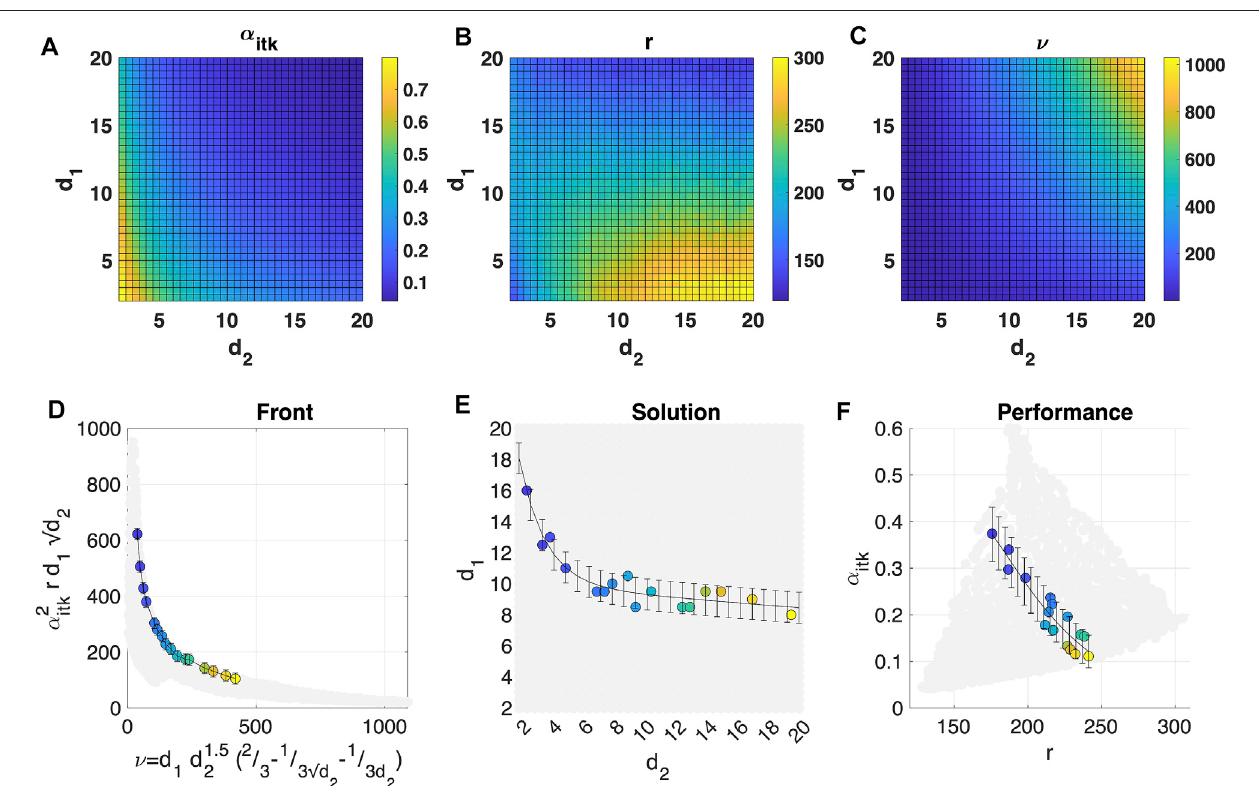
FIGURE 9 | (A) Intake transmission α itk , (B) compression r , and (C) volume utilization ] vs. intake aspect ratio d 1 and area ratio d 2 ranging between 2 and 20. Simulated species: N 2 . Figure resolution: 37 × 37 simulations. Simulated particles for each simulation: 1e5. (D) Front, (E) solution, and (F) performance maximizing (cid:19)(cid:19)(cid:19) (cid:22) α 2 d 2 for ] constrained between 50 and 450, as obtained by a sorting algorithm from the 37 × 37 simulations dataset. Optimal data are interpolated by a double itk rd 1 exponential fi t (continuous black line).